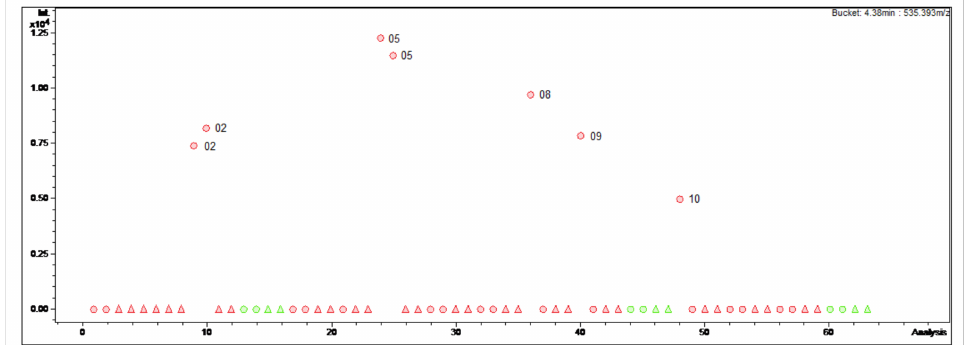
Figure 2. Bucket statistic of Cyclomicrophyllidine-B (( 7 ); 4.38 min: 535.393 m/z ) in ProfileAnalysis 2.1. Legend: round dots = B . sempervirens var. suffruticosa ; triangle = B . sempervirens var. arborescens ; red = leaf; green = twig; number =